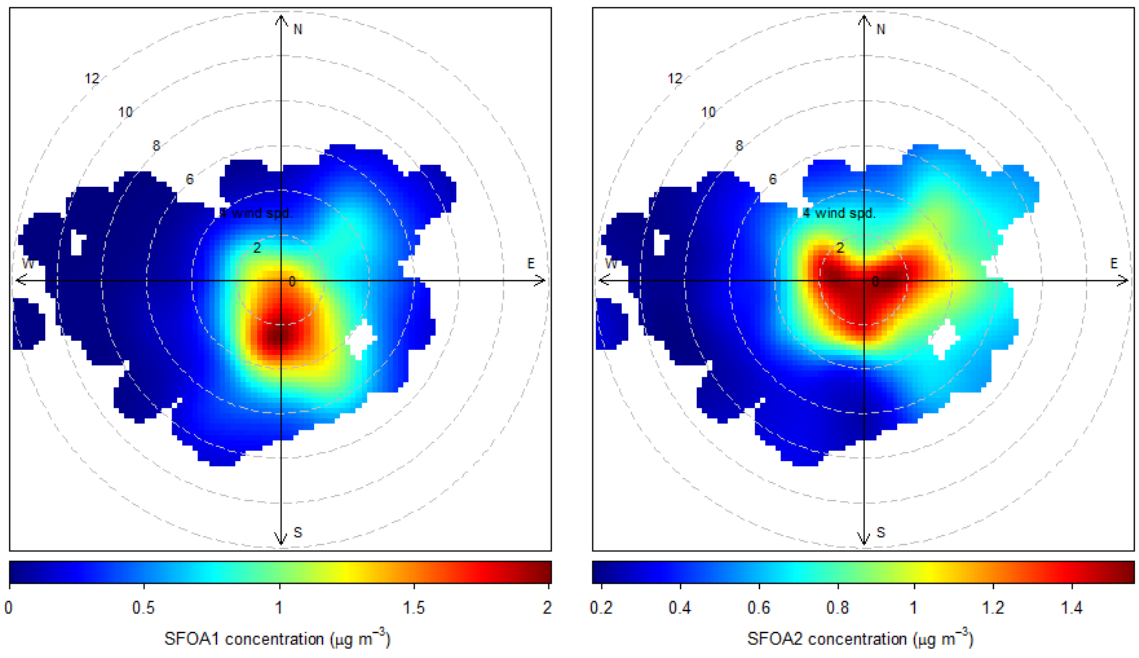
Figure 3. Polar plots of hourly averaged SFOA1 (left) and SFOA2 (right) concentrations as a function of wind speed and direction, where the wind data are from the Heathrow airport meteorological station, which are unaffected by large buildings. These polar plots were plotted in R using the openair package (Carslaw and Ropkins, 2012; Carslaw, 2013) which is a data analysis tool used to investigate air